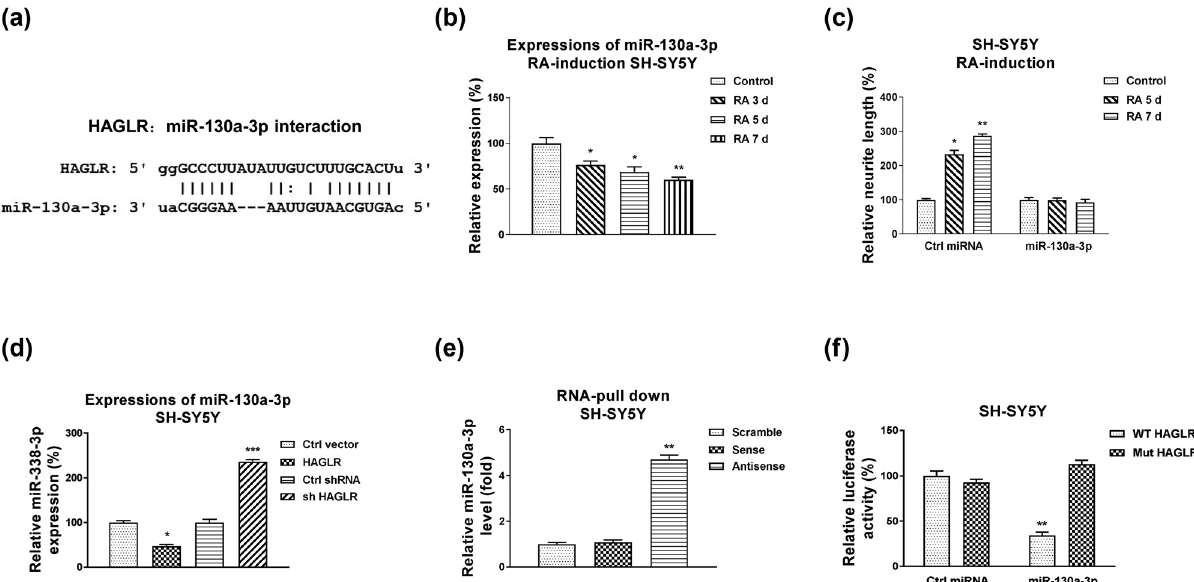
Figure 2: HAGLR sponges miR - 130a - 3p to negatively regulate its expression. ( a ) Bioinformatics analysis of potential binding of HAGLR on miR - 130a - 3p. ( b ) SH - SY5Y cells were treated with 5 µM RA for 3, 5, and 7 days. miR - 130a - 3p expressions were examined by qRT - PCR. ( c ) SH - SY5Y cells were transfected with control miRNA or miR - 130a - 3p for 48 h, followed by treatments with 5 µM RA for 5 and 7 days. Cell morphologies were examined under a microscope, and the neurite length was measured. ( d ) SH - SY5Y cells were transfected with control, the HAGLR overexpression plasmid, or HAGLR shRNA for 48 h; miR - 130a - 3p expressions were examined by qRT - PCR. ( e ) SH - SY5Y cell lysates were incubated with biotin - labeled scramble, sense, or antisense HAGLR DNA probes. Biotin pull - down assay was performed, and miR - 130a - 3p expression was assessed by qRT - PCR. ( f ) Dual - luciferase reporter assay was performed in SH - SY5Y cells with co - transfection of WT - HAGLR or Mut - HAGLR with control miRNA, or miR - 130a - 3p. * p < 0.05; ** p < 0.01; and *** p <